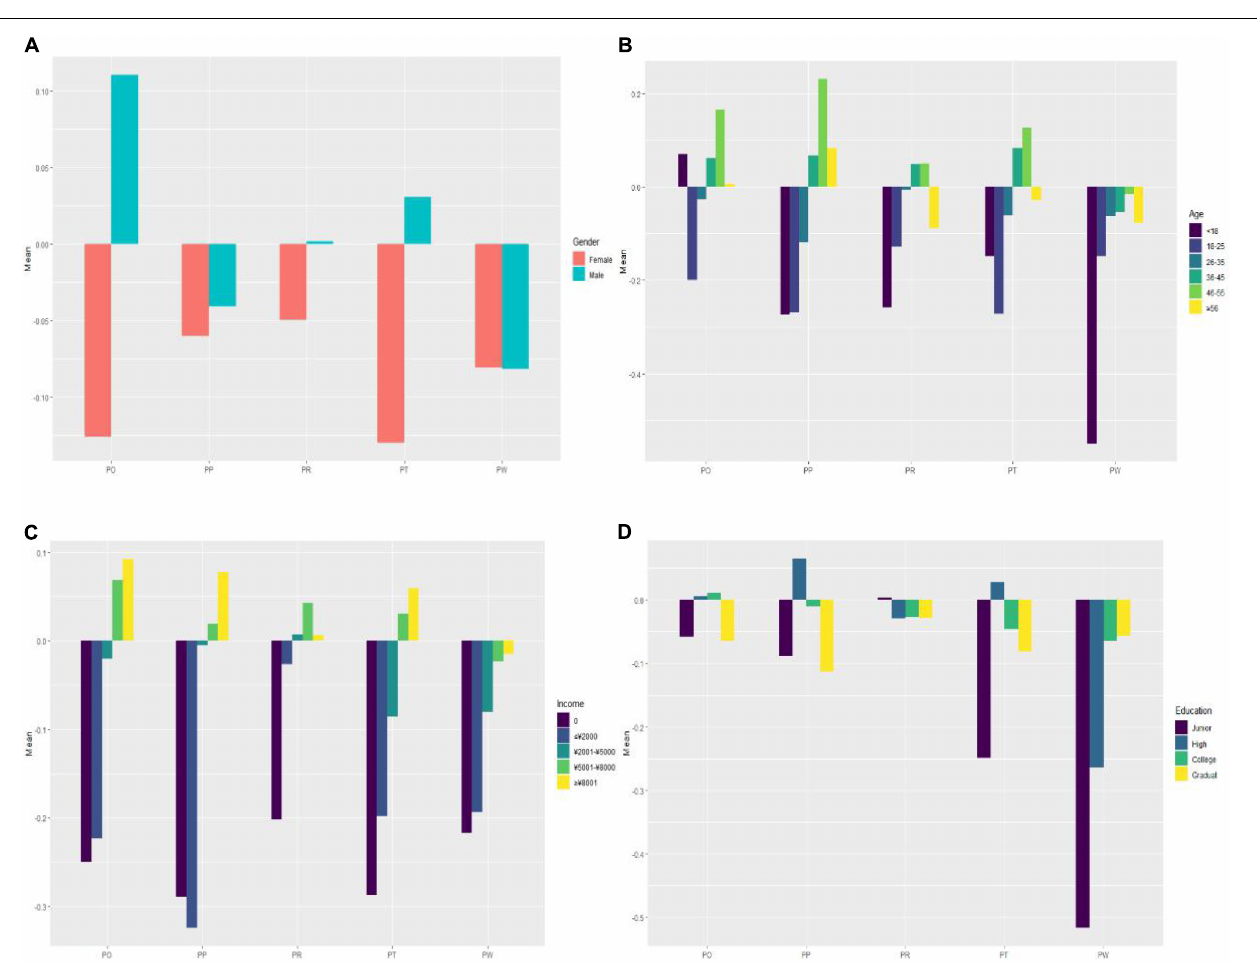
FIGURE 2 | Consumer purchase behavior changes by demographic characteristics. (A) Consumer purchase behavior changes by gender. (B) Consumer purchase behavior changes by age. (C) Consumer purchase behavior changes by monthly income level. (D) Consumer purchase behavior changes by education attainment.